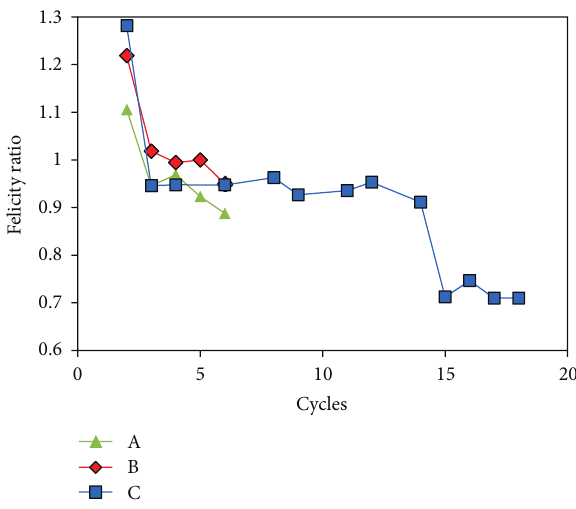
Figure 7: Felicity ratio for different